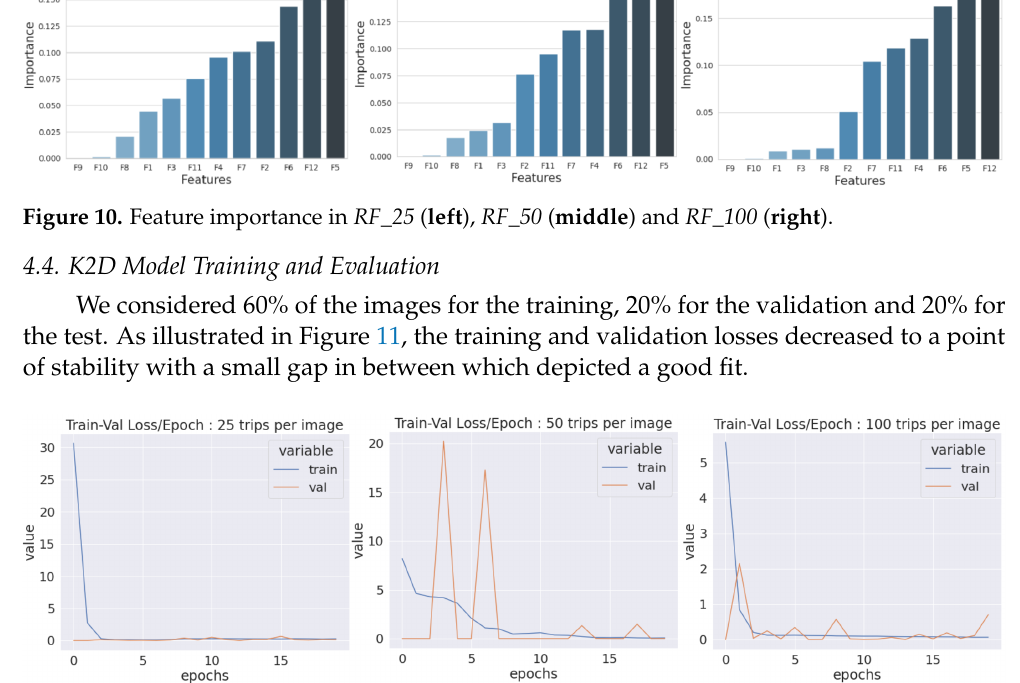
Figure 11. Training (blue) and validation (orange) losses per epoch for K2D_25 ( left ), K2D_50 ( middle ) and K2D_100 ( right